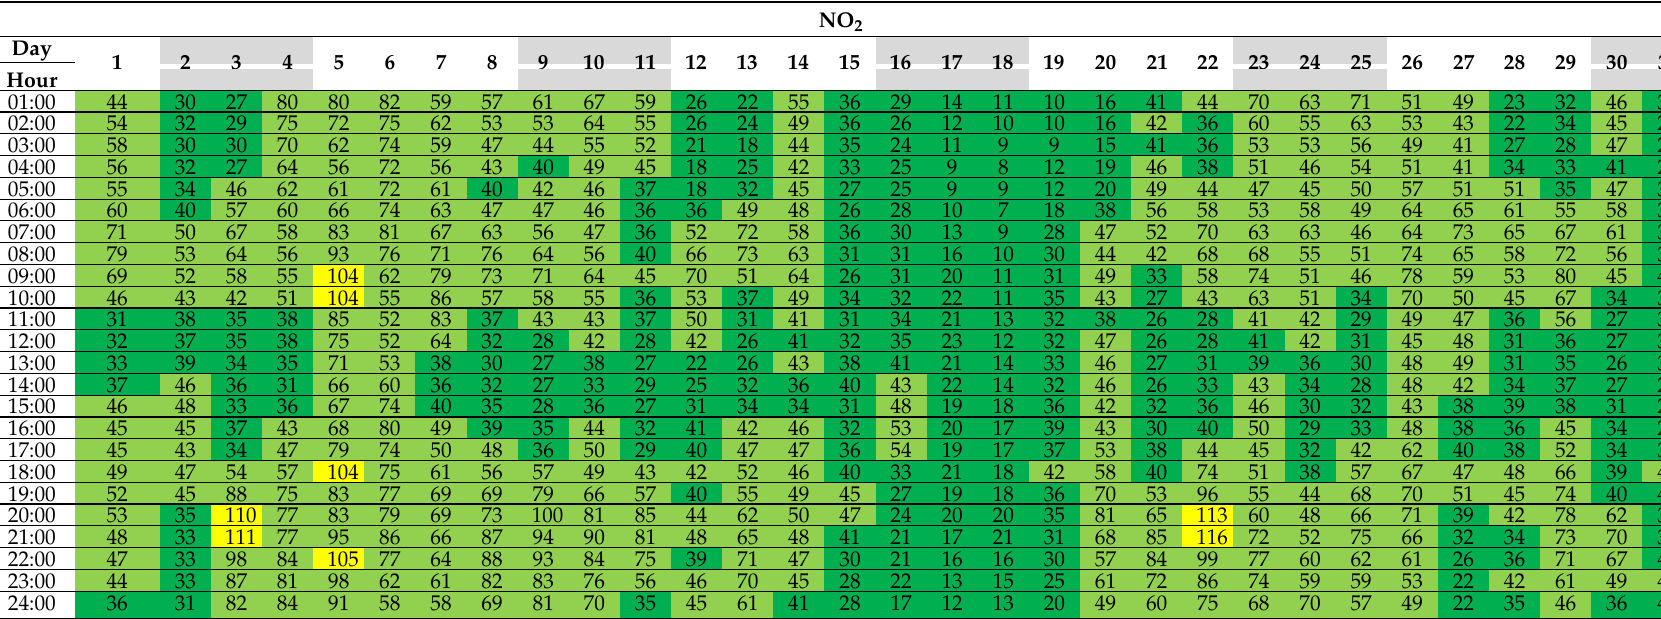
Table 4. Daily and hourly NO 2 content changes, with the hourly Polish AQI, average values for Krak ó w, March 2018 [39] (weekend marking in